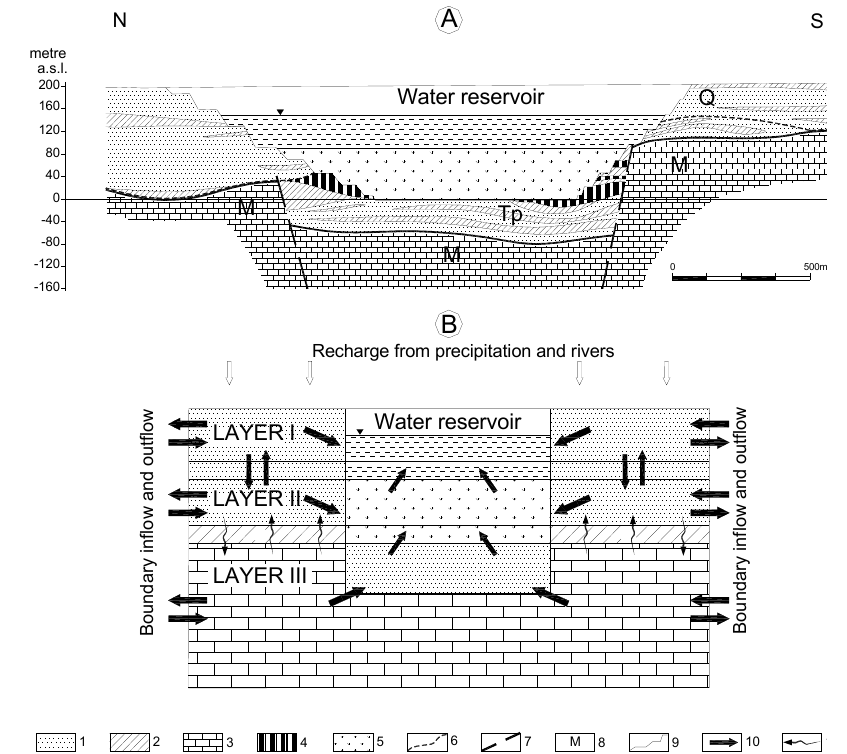
Figure 2. Simplified geological cross-section through the post-mining void ( A ) with the conceptual model suitable for numerical modeling ( B ). Explanation: 1 —porous, permeable formations; 2 —impermeable and slightly permeable formations; 3 —fissured-karstic formations; 4 —lignite; 5 —internal dump; 6 — boundary of the Quaternary aquifer; 7 —faults; 8 —symbols of aquifers; 9 —open-pit limits; 10 —direction of groundwater flow; 11 —direction of groundwater percolation [44].